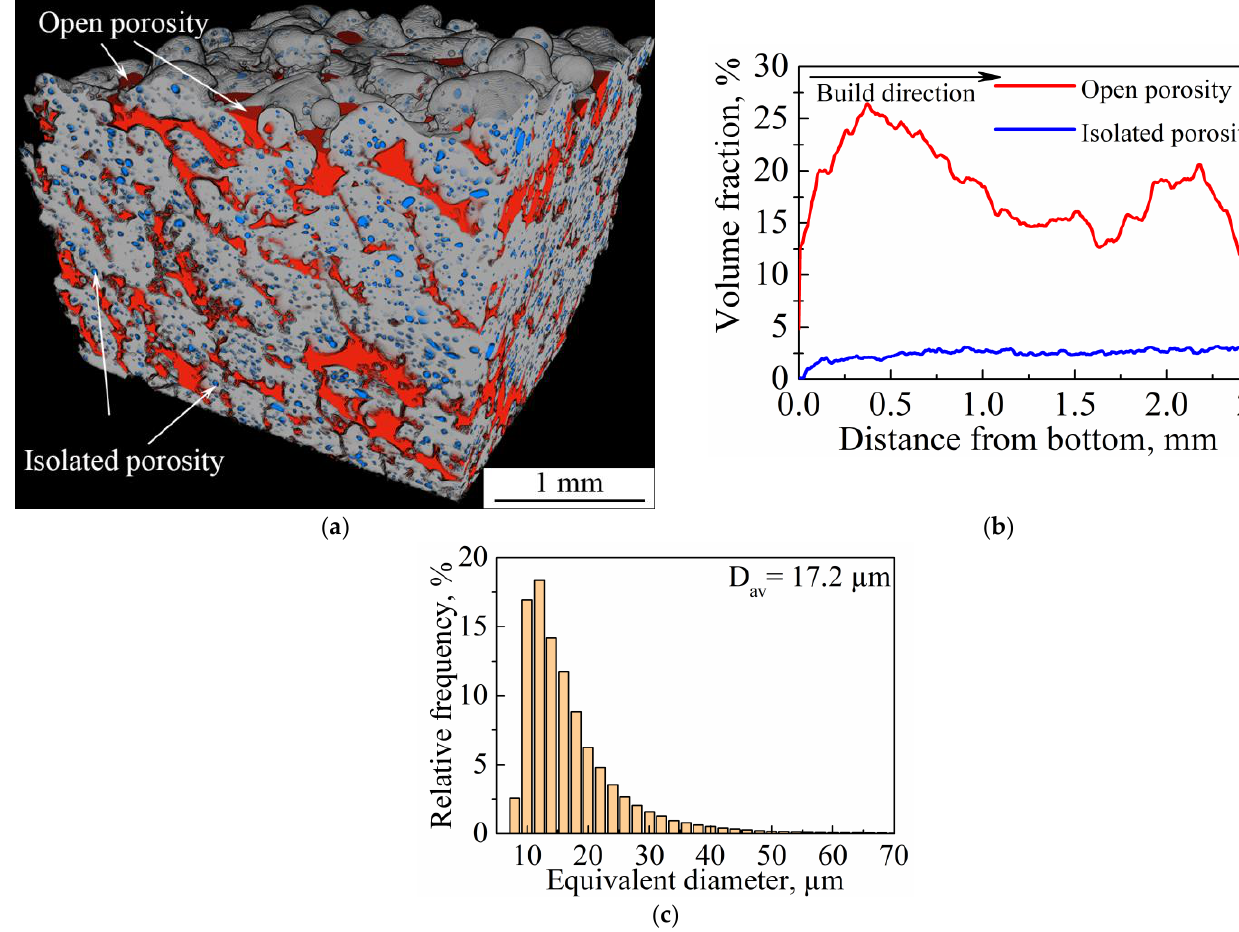
Figure 16. ( a ) Three-dimensional rendering of segmented voids in a section of a studied porous sample; ( b ) the volume fraction of open and isolated porosity as a function of distance from the sample’s bottom; ( c ) size distribution of isolated porosity (D av is the average pore size).